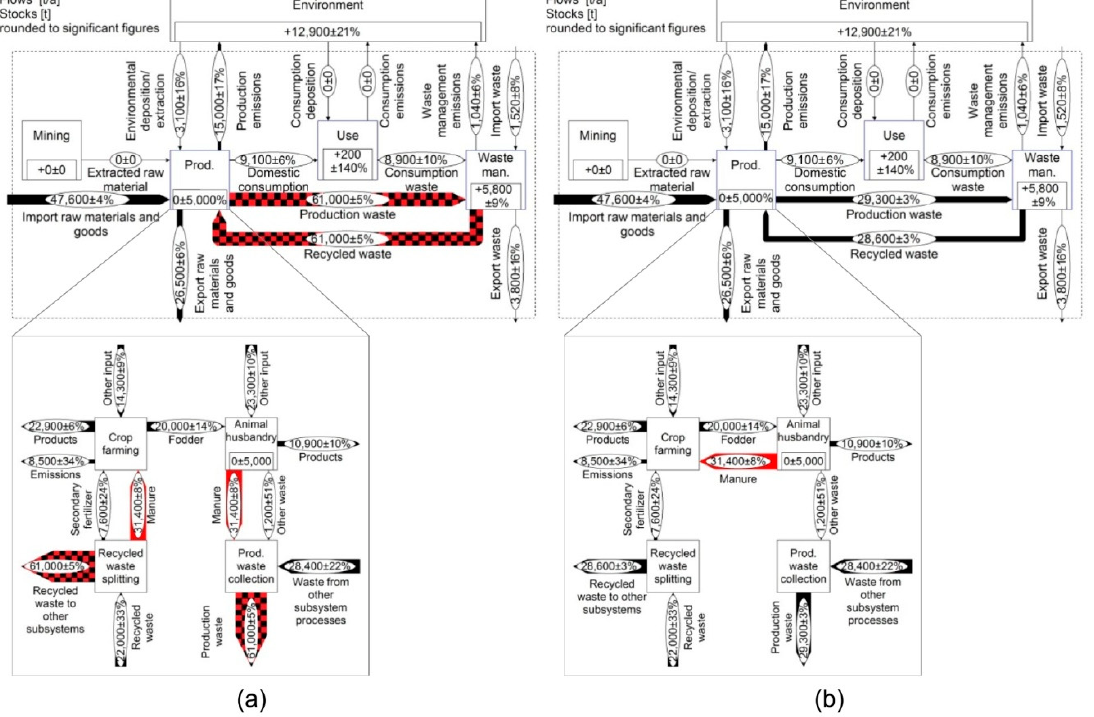
Figure 8. Comparison of alternate forms of manure definition in the Austrian P system 2015. Generic topmost layer and schematic detail of the subsystem production if ( a ) manure is defined as recycled waste and ( b ) as a co-product. Manure flows are marked in red and checkered pattern indicates inclusion of manure.